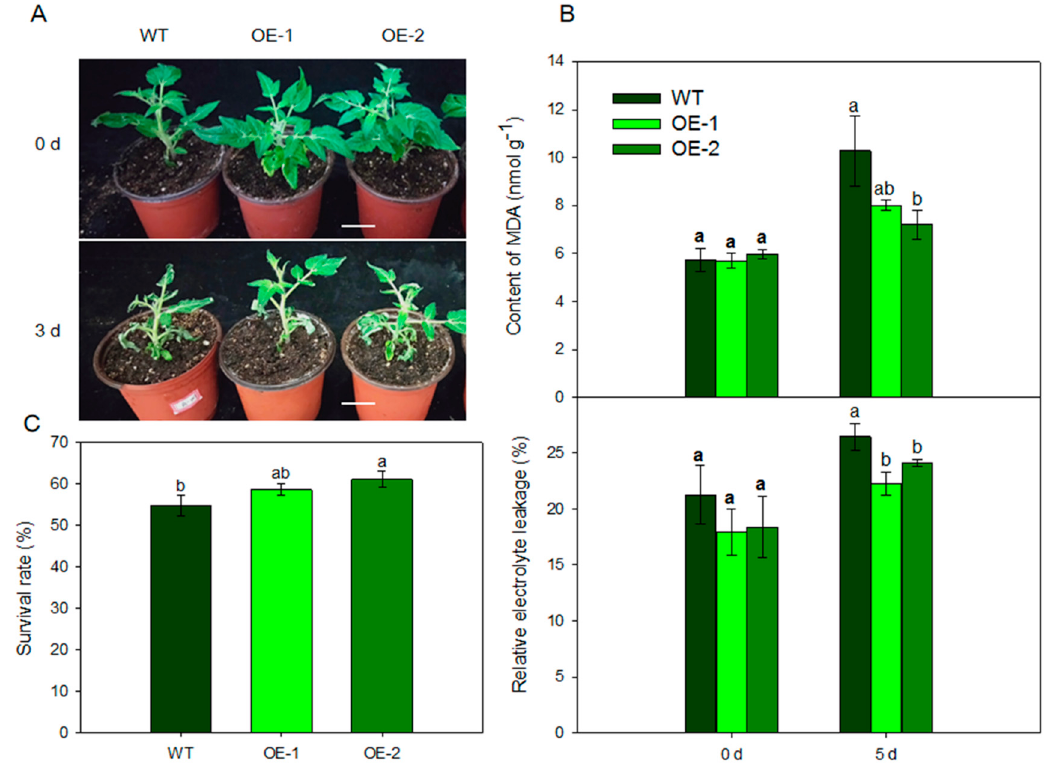
Figure 6. Effects of MdARD4 overexpression in tomato on the degree of plant damage under cold conditions. ( A ) Phenotype comparisons between WT and MdARD4 transgenic plants. Bar, 5 cm; ( B ) relative electrolyte leakage and MDA concentrations of WT and MdARD4 -overexpression plants; and ( C ) survival rates of WT and MdARD4 -overexpression plants. Data are means of three replicates with SD. Different letters indicate significant differences between WT and transgenic plants on the same day of different treatments, according to one-way ANOVA Tukey’s multiple range tests ( p < 0.05).